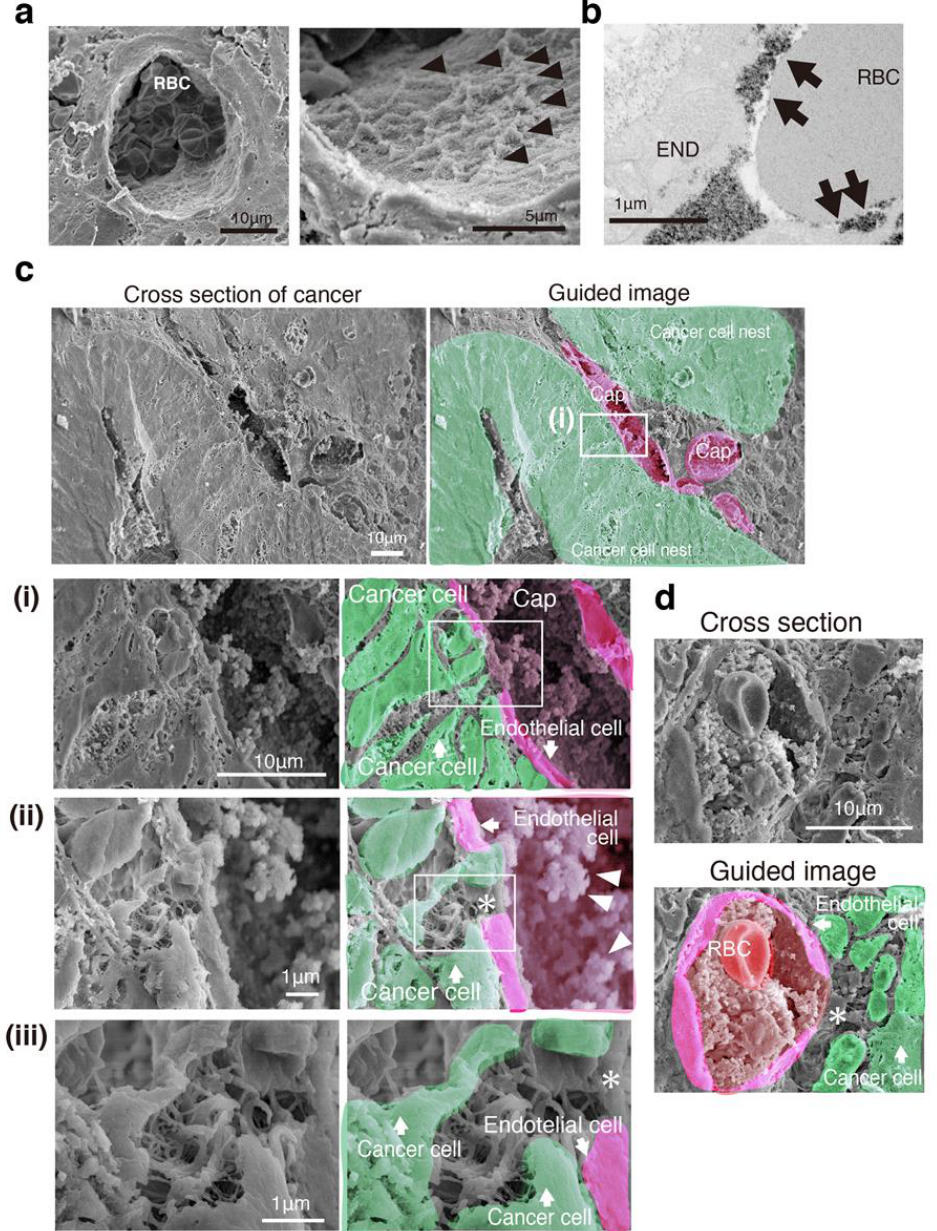
Figure 2. Three-dimensional network structure of a cancer capillary channel surrounded by human CRC cells. ( a ) SEM image with lanthanum nitrate of a vessel in normal-appearing mucosa. Right image: High magnification of the left image. Arrowheads indicate 3D mesh-like endothelial glycocalyx (GCX). RBC: Red blood cell. ( b ) TEM image with lanthanum nitrate of a vessel in normal-appearing mucosa. Arrows indicate moss-like endothelial GCX. RBC: Red blood cell. END: Endothelial cell. ( c ) SEM image with lanthanum nitrate (left) and guided image (right) showing the relationship between cancer cell nests and capillary vessels in a cross section. Cap: Capillary. (i–iii) High-magnification image (left) and guided image (right) of the rectangles in ( i–iii ), respectively. Asterisk indicates uncoated capillary wall. ( d ) A pore of the capillary opened and connected to the network structure composed of the cancer cells themselves in another patient. RBC: Red blood cell. Asterisk: A pore of the